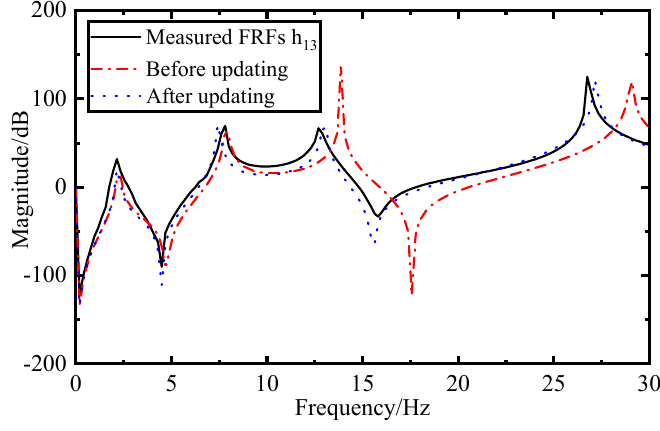
Figure 16. Comparison of FRFs h 13.